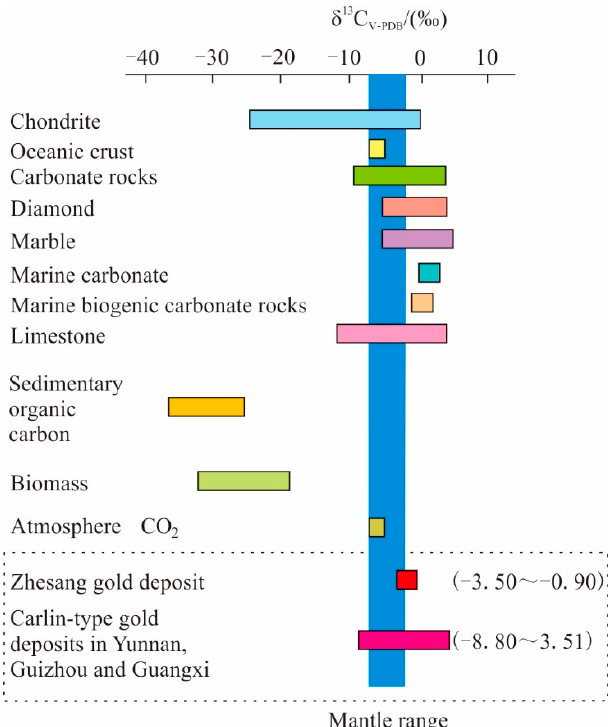
Figure 9. Comparison diagram of carbon isotopic compositions [60].